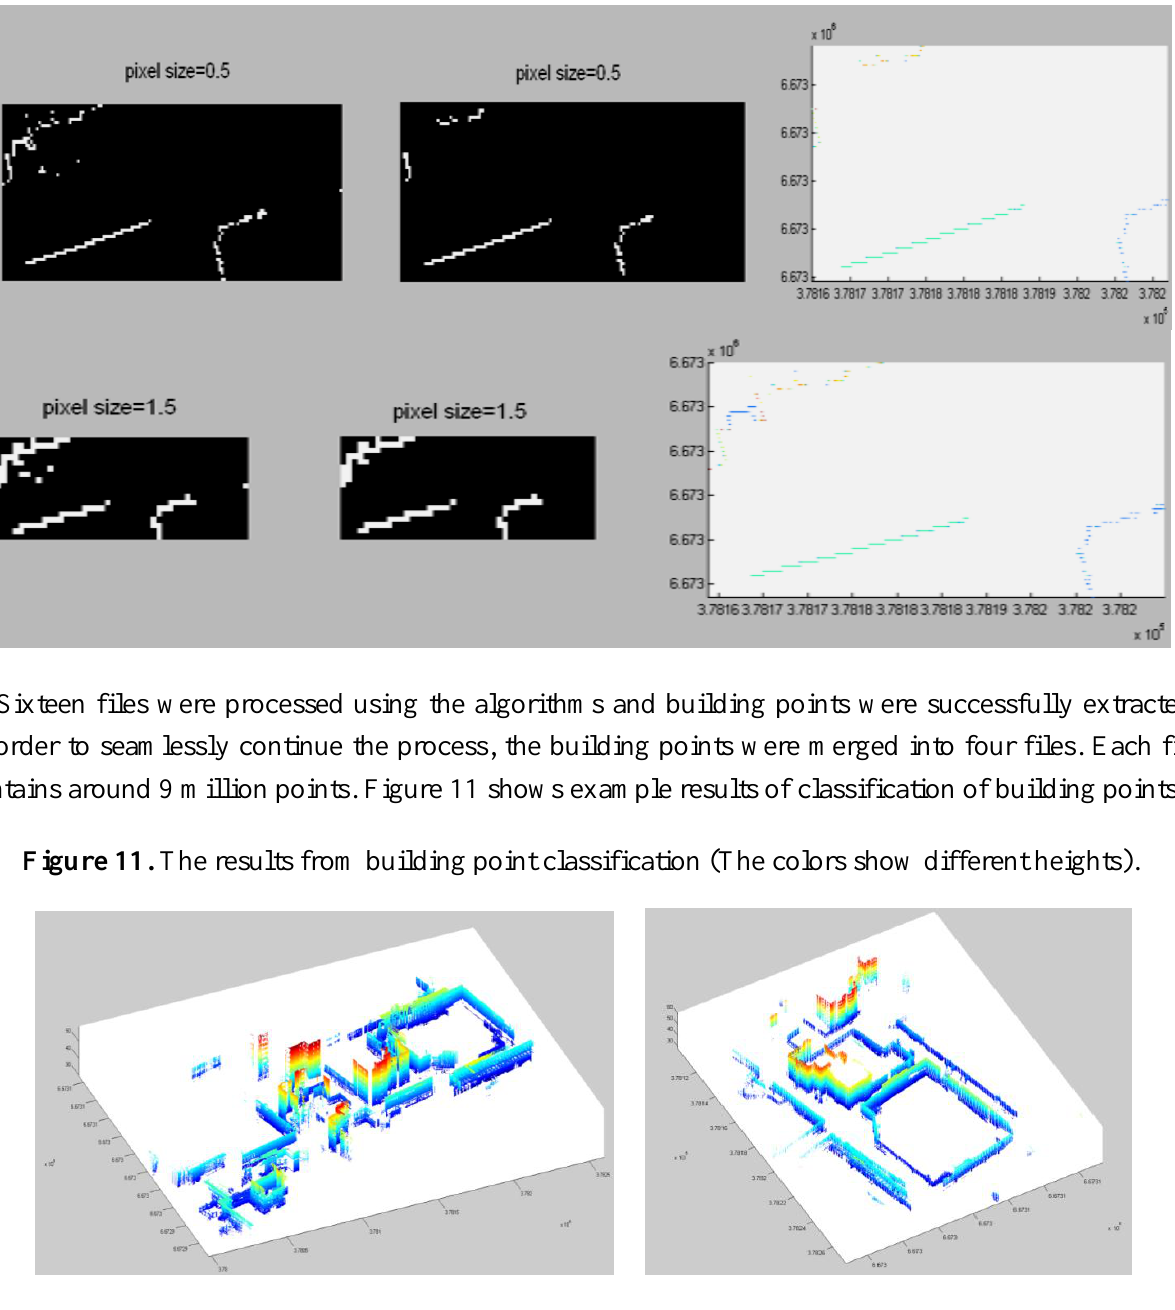
binary image). Left : image with noise points; Middle : image after noise removal; Right : results in 3D points; Upper : images with pixel size of 0.5 m; Lower : images with pixel size of 1.5 m.